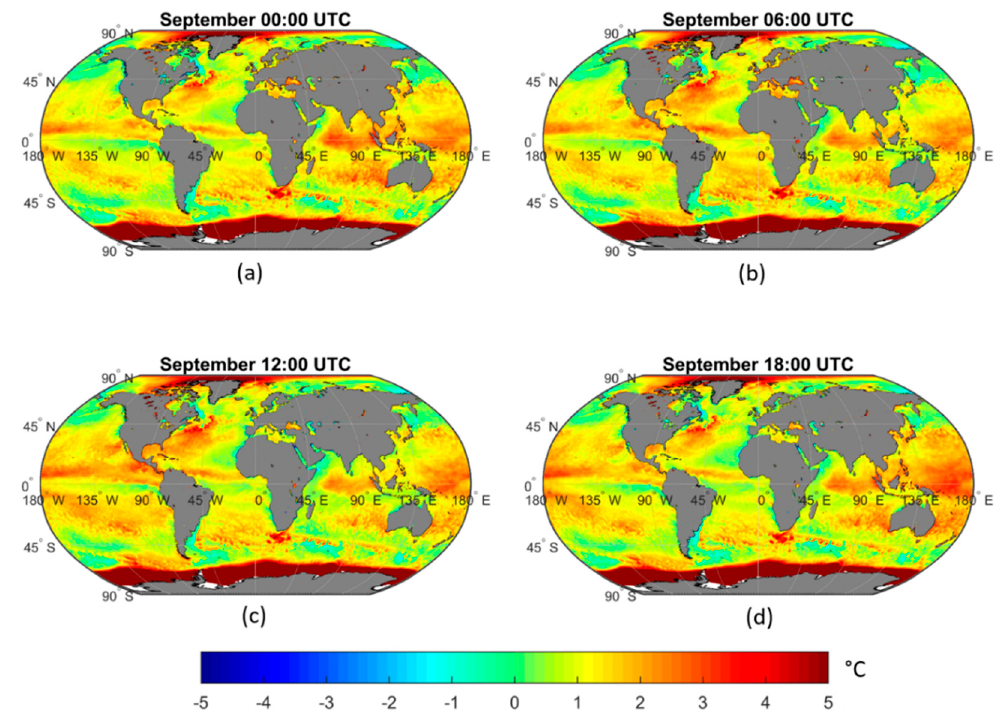
Figure A3. Global maps of monthly average of SST- t2m in the month of September 2018, calculated using ERA5 data [18], for the time steps ( a ) 00:00 UTC; ( b ) 06:00 UTC; ( c ) 12:00 UTC; ( d ) 18:00 UTC.